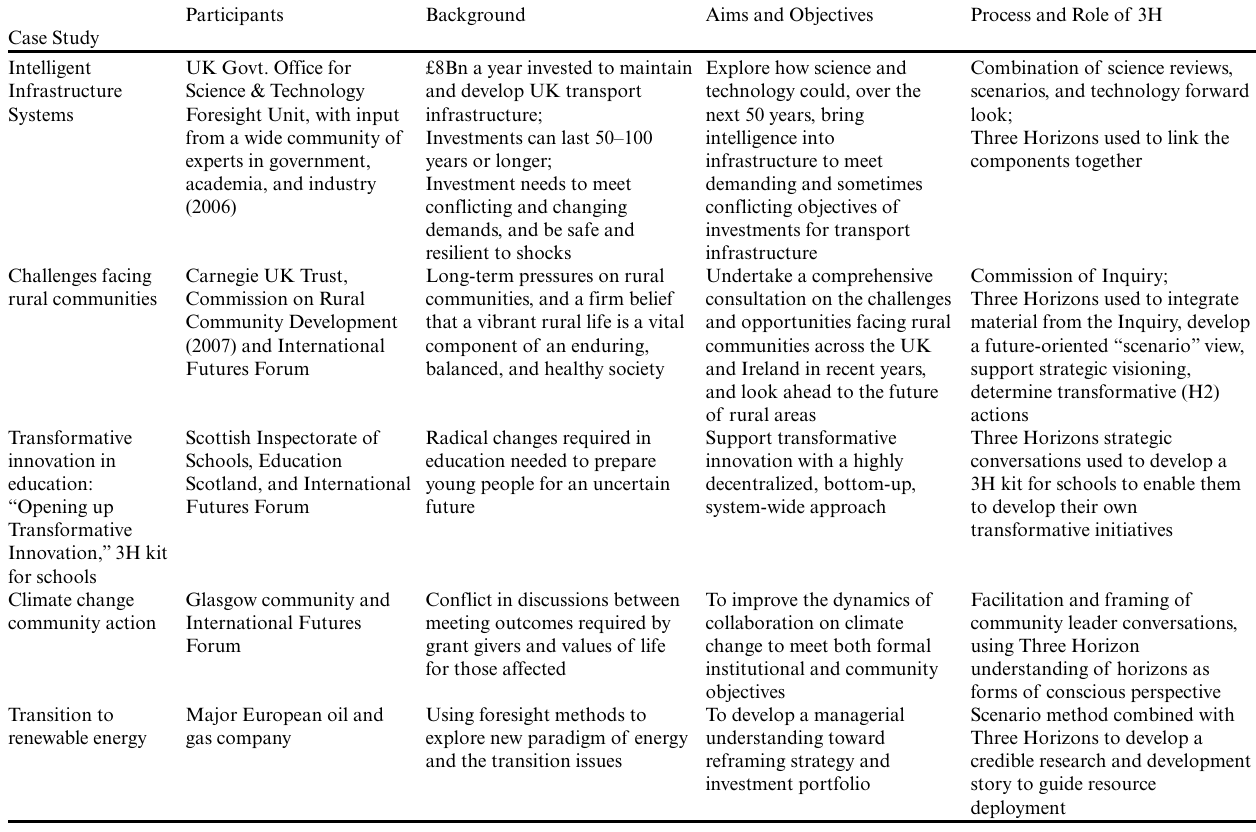
Table 1 . Examples where Three Horizons (3H) dialogue has been used to facilitate change and